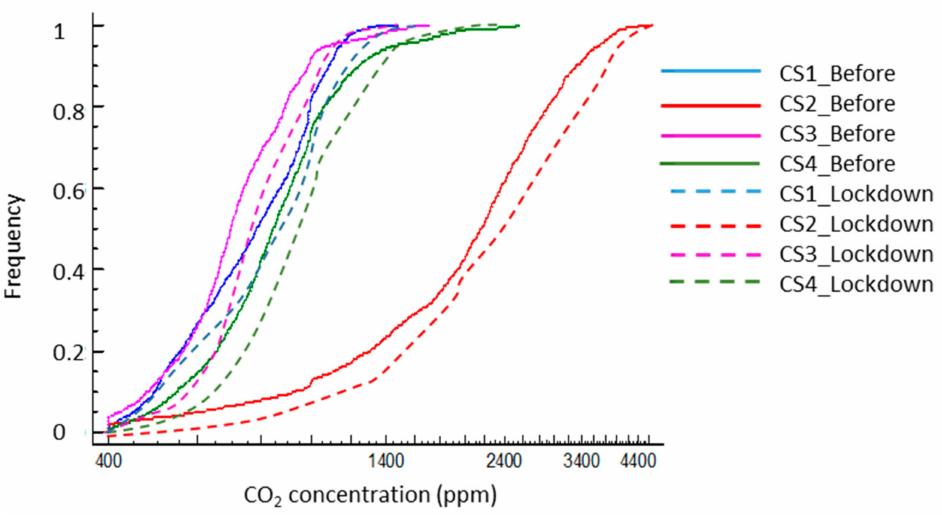
Figure 10. Quantile graph for indoor CO 2 concentration before and during the